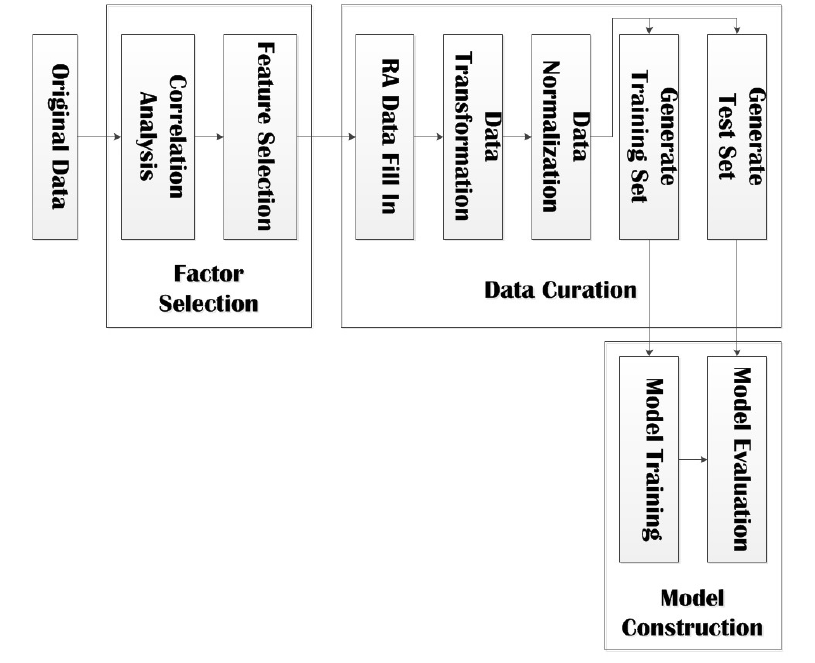
Figure 2. Flow of the prediction